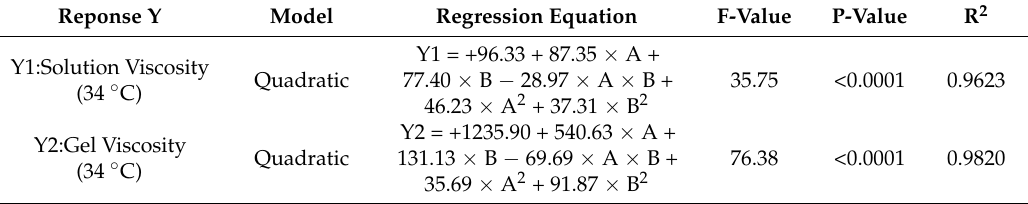
Table 4. Regression equations of the fitted